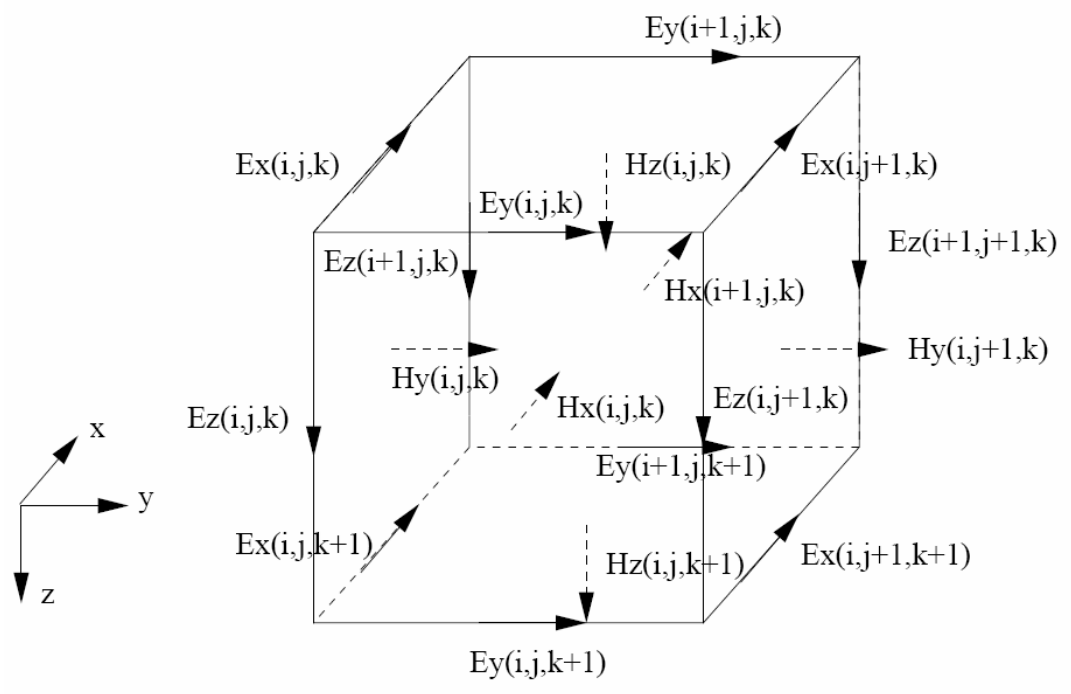
Figure 1. Definition of the electric and magnetic field components on the staggered grid.